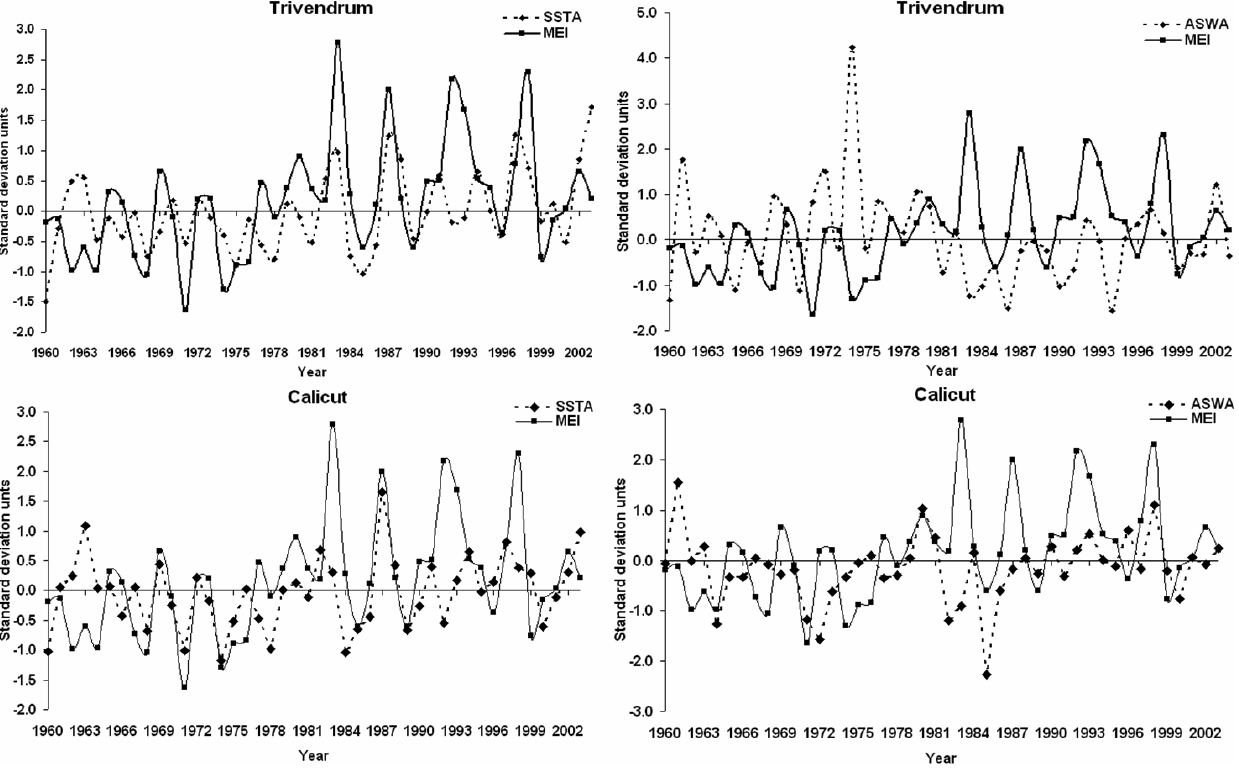
Fig. 2. 1960–2003 standardized time series of SSTA (bold, left panel) and AWSA (bold, right panel) for selected 1 ◦ × 1 ◦ located along the southwest coast of India. Superimposed is the time series of the April–May MEI (dot) of the year.